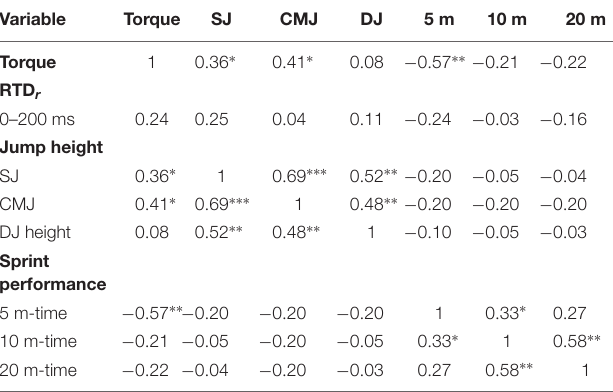
TABLE 4 | Relationship between the individual relative changes of the different performance